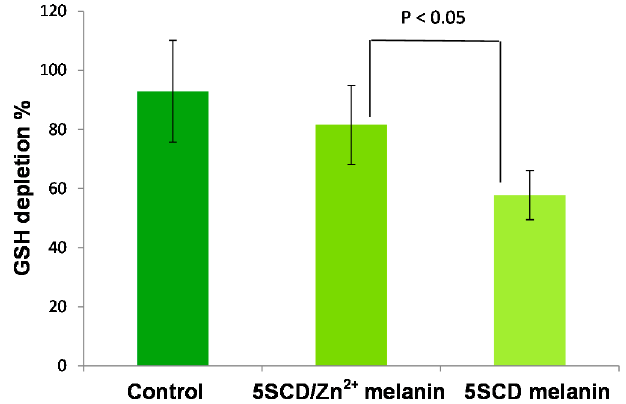
Figure 8. Glutathione (GSH) depletion (%) after 3 h in 0.1 M phosphate buffer (pH 7.4) in the absence or in the presence of 5SCD melanin prepared in the absence or in the presence of Zn 2+ ions. Reported are the mean ± SD values from at least five experiments. Significant differences were determined by an independent sample two-tailed t